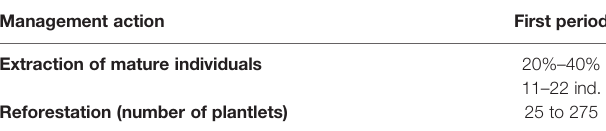
TABLE 5 | Different combinations of thresholds of management actions to maintain l above unity in the population Pino Real during the fi rst monitoring period of the study.